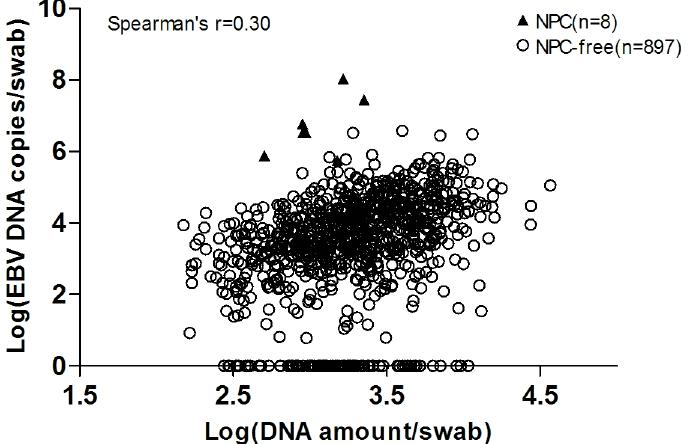
Fig 1. Relationship of EBV DNA load and DNA amount in the nasopharyngeal swabs. The swab EBV DNA load showed only a modest correlation with the DNA amount in the nasopharyngeal swabs (Spearman ’ s correlation coefficient = 0.30, P <